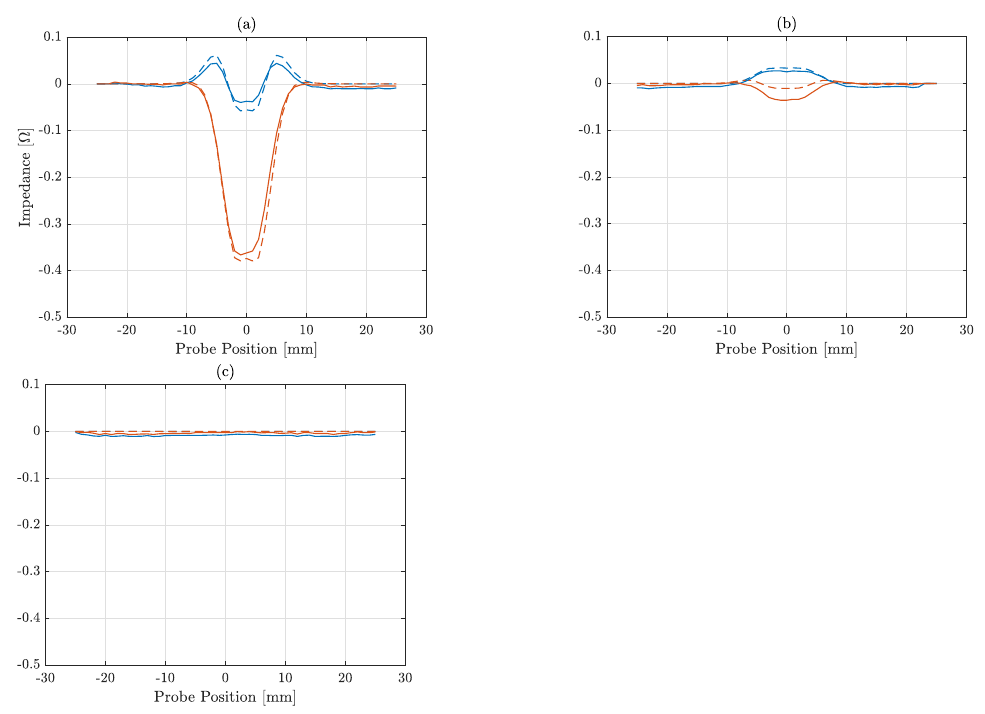
Figure 3. Experimental set-up for EC measurements, composed by a NORTEC 600 connected to a low-frequency Olympus probe and a data acquisition device (PicoScope 5244B—bandwidth 200 MHz, 16 bit).